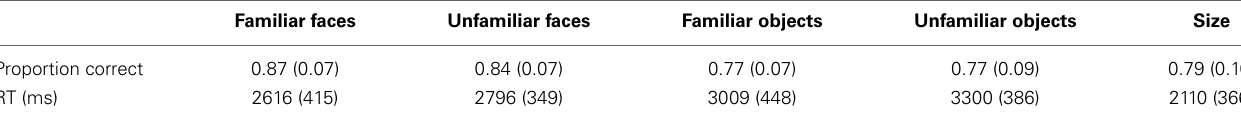
Table 1 | Mean accuracy and reaction time (correct trials only) for each condition (reproduced from Barense et al.,